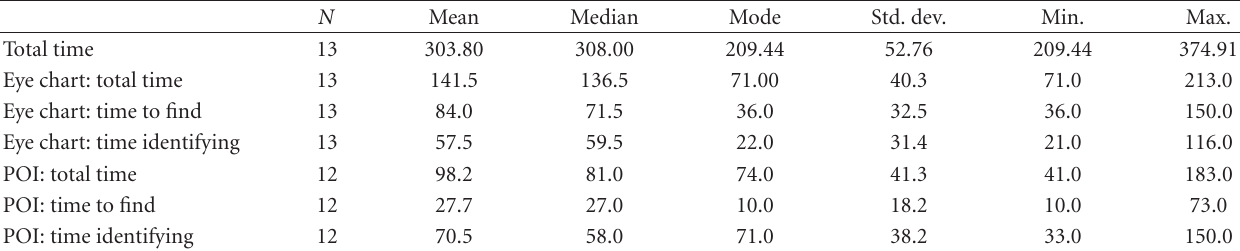
Table 2: Times descriptive statistics (in seconds).